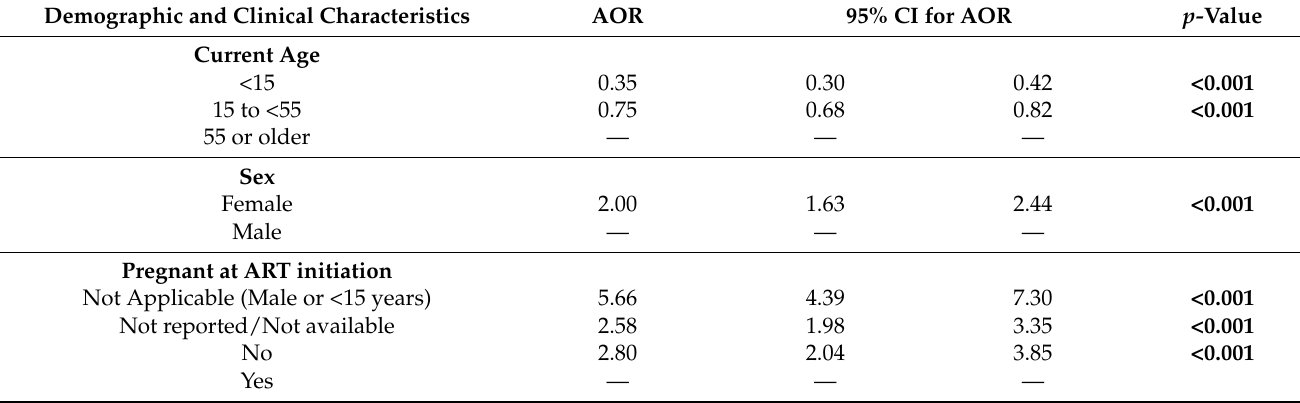
Table 3. Logistic Regression of Retention of Persons Living with HIV in Care (N =